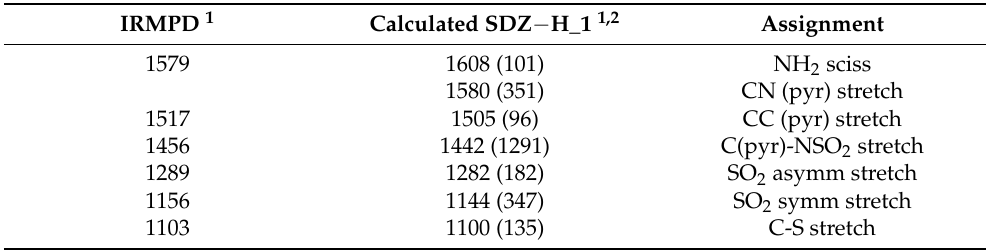
Table 1. Observed IRMPD bands of the (SDZ − H) − anion and calculated vibrational frequencies of SDZ − H_1